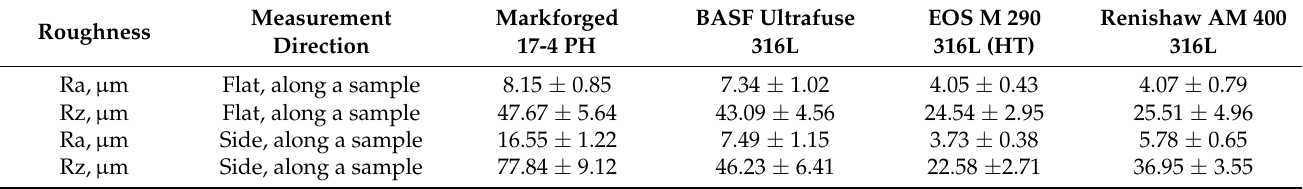
Table 7. Average and standard deviation (mean ± standard deviation) of the surface roughness of fatigue